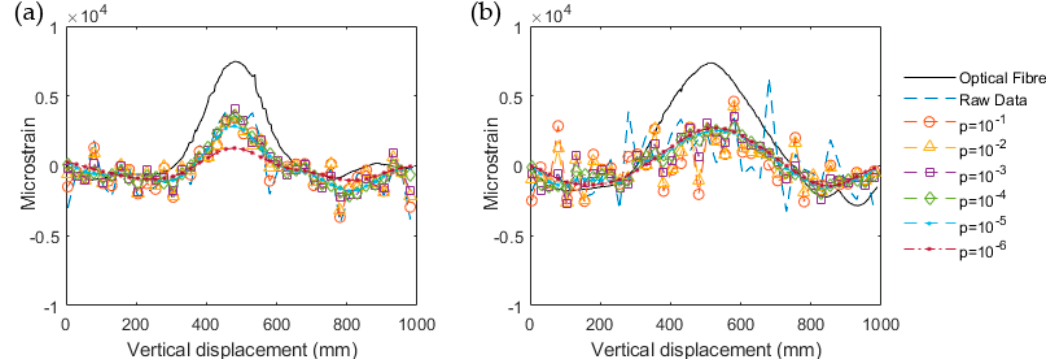
Figure 12. OOP deformation test Step 6: Strain along the vertical line ( a ) at 800 mm and ( b ) at 1000 mm for different (cid:2198) parameters, no filter, and optical fibre.